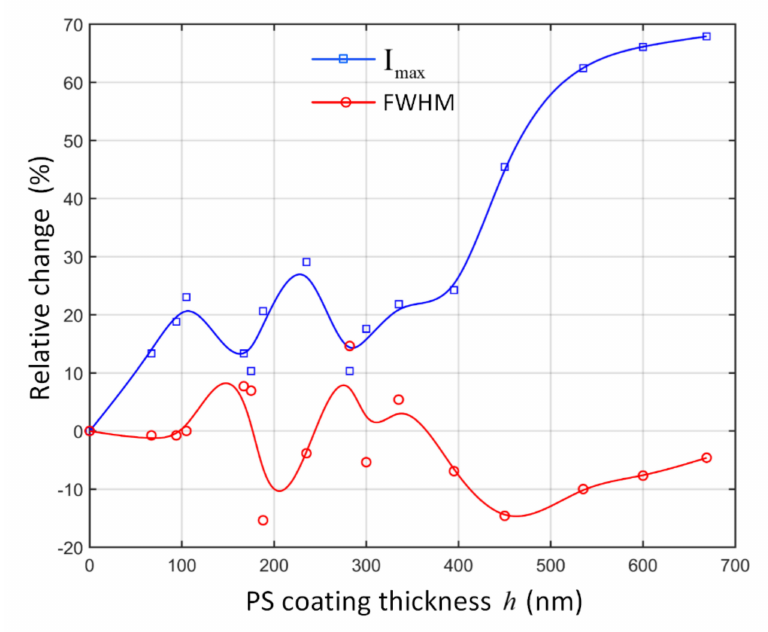
Figure 6. Relative change of the FWHM and maximum optical intensity of PNJs for a 2.5 µ m-core-radius BTG sphere with di ff erent PS coating thickness. The h = 0nm corresponds to the uncoated BTG